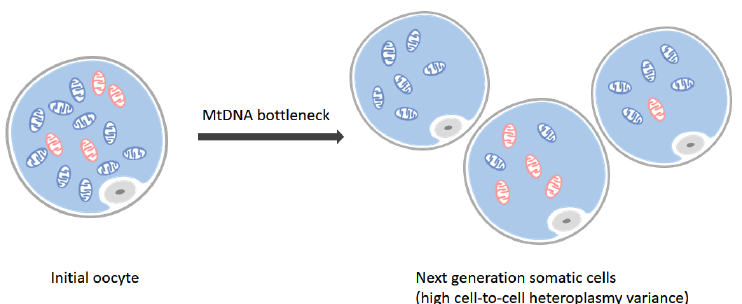
Figure 1. Bottleneck effect. There are two types of mtDNA in initial oocyte ( left ), where blue stand for mitochondria harboring wild-type mtDNA and red ones represent mutated ones. During the meiosis acting under the mtDNA bottleneck effect, the mitochondria in next generation somatic cells take on a high cell-to-cell heteroplasmy variance situation ( right ). Some of them may harbor all wild-type mtDNA while others accumulate one or more mutations.